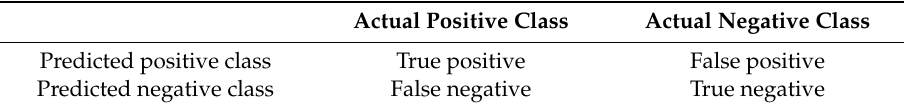
Table 1. An example of a confusion